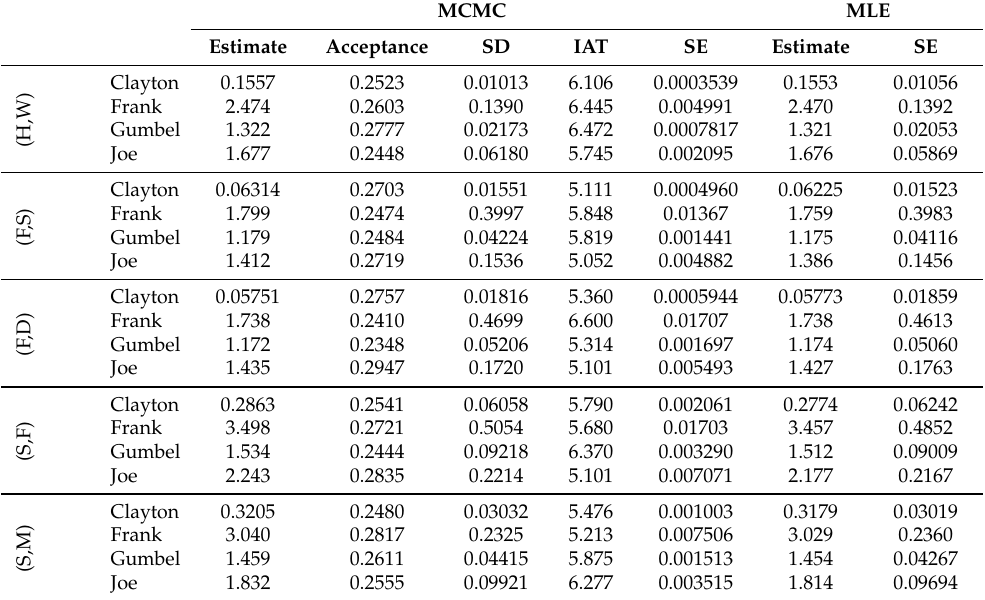
Table 6. Copula dependence parameter estimation results for all five data sets. MCMC: estimate, acceptance rate, standard deviation (SD), integrated autocorrelation score (IAT) and standard error (SE). MLE: estimate, SE.